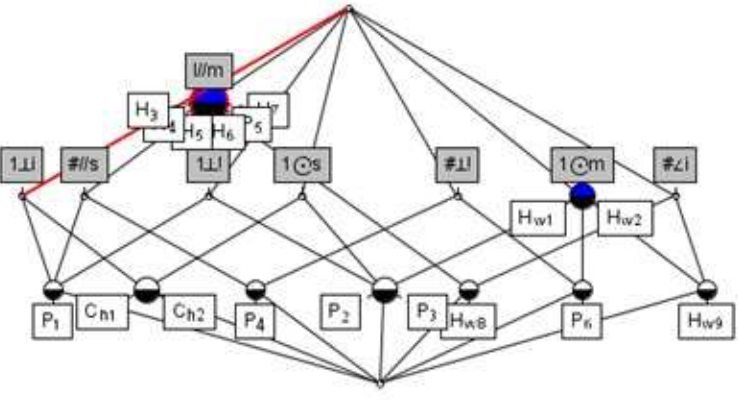
Figure 7. The formal concept lattice of Table